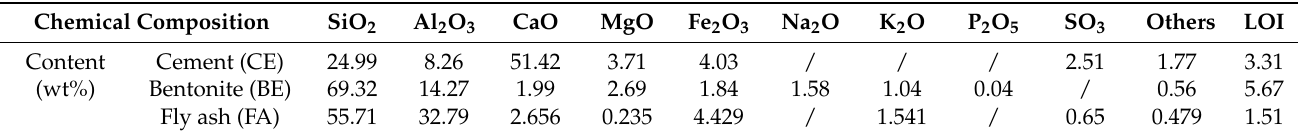
Figure 4. ( a ) Particle size distributions ( b ) XRD of FA ( c ) XRD of BE ( d ) XRD of CE. Table 2. The compositions of CE, BE, and